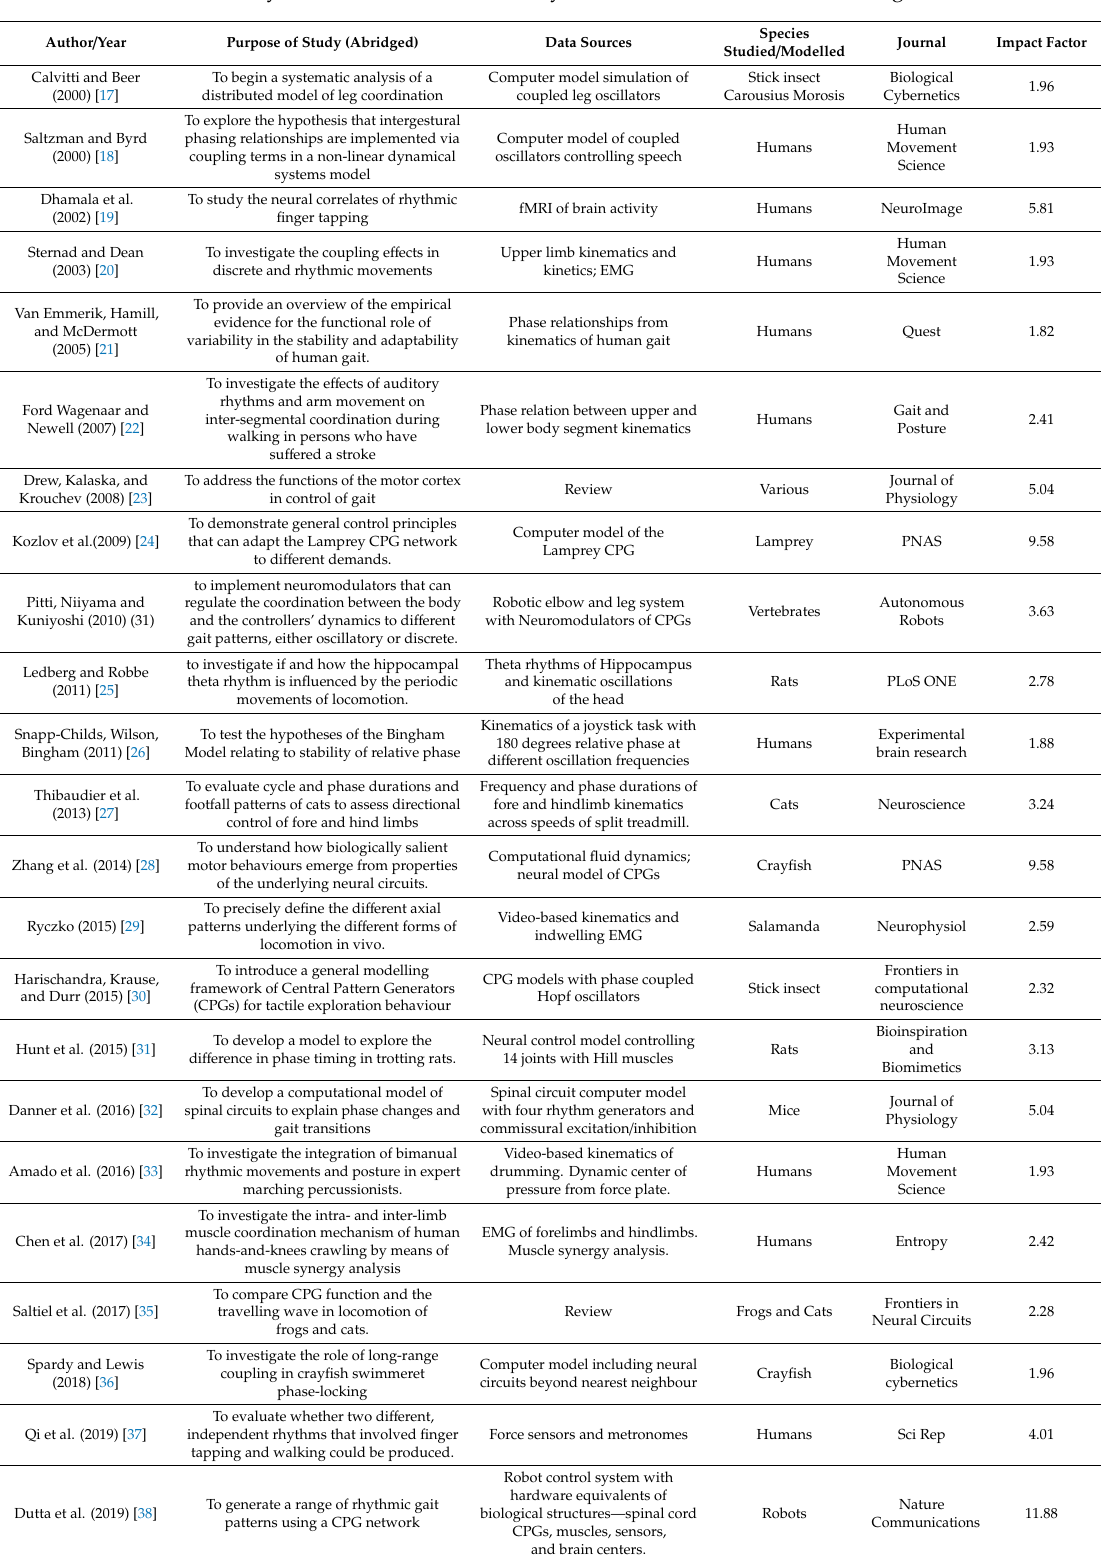
Table 4. Summary of articles screened in the systematic search listed in chronological